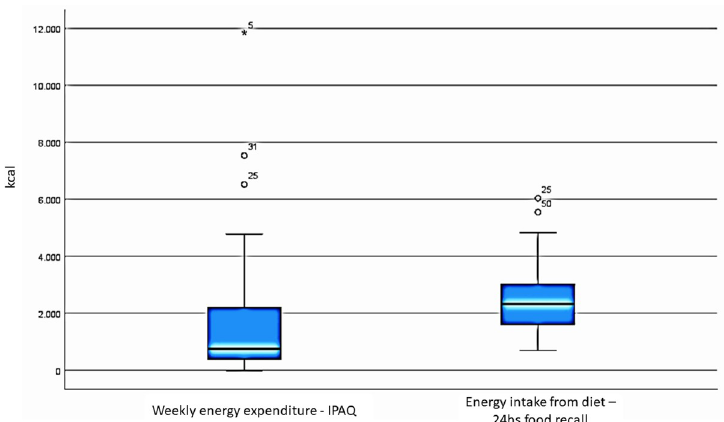
Fig 1. Physical activity expressed in weekly energy expenditure (A) and Energy intake from diet (B) in the study cohort.